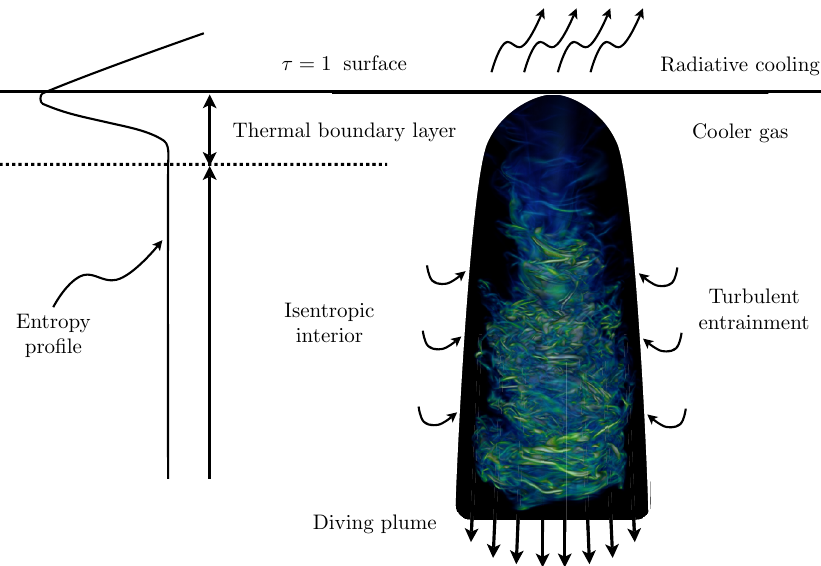
Fig. 2 Left: the entropy profile as a function of depth, as estimated by numerical simulations or one- dimensional structure models. Right: numerical vizualisation a cool plume diving from the surface. As it penetrates into the isentropic background, the plume increases both its mass and momentum flux by turbulent entrainment (represented by curly arrows) and expands horizontally. Image credits: Mark Rast, see Clyne et al.